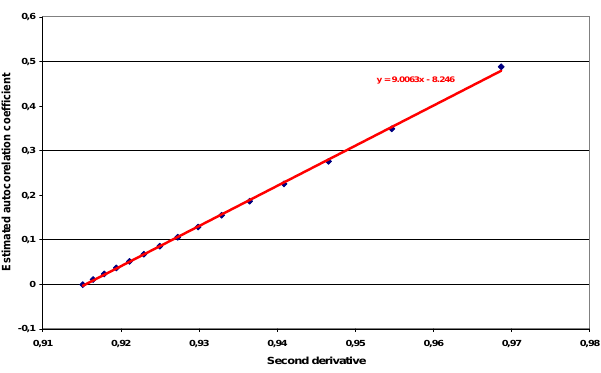
Fig. 15. Copper concentration (ppm) values from Main KTB bore- hole together with mean values for 101m long segments of drill- core. Locally the original data (blue diamonds) deviate strongly from the moving average (pink